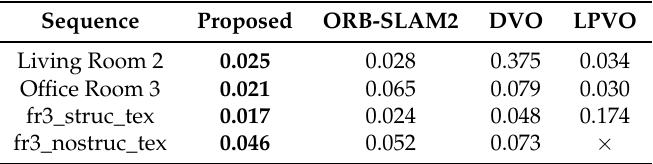
Table 3. Comparison of ATE.RMSE (unit: